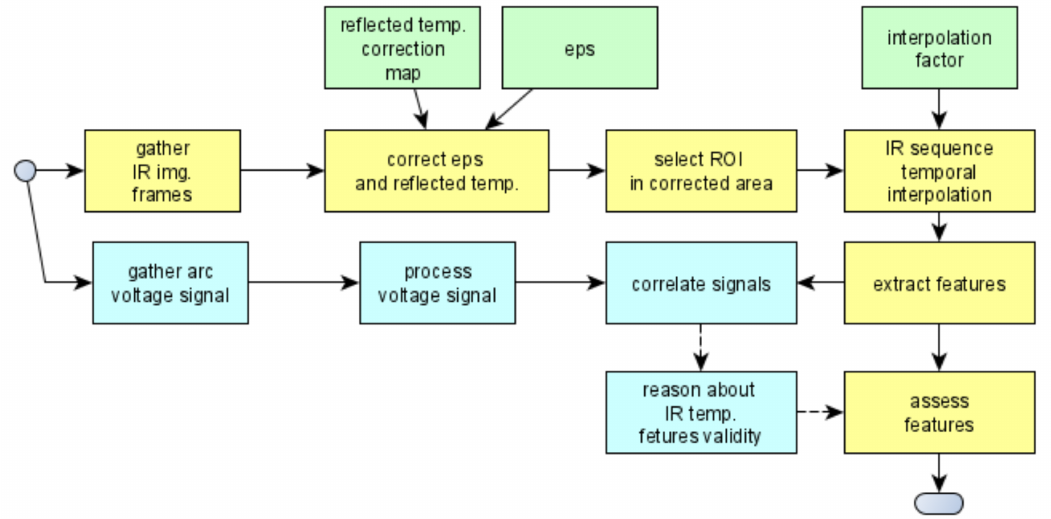
Figure 4. Detection of weld defects based on interpolated infrared (IR) sequences with the step of voltage = temperature distribution features